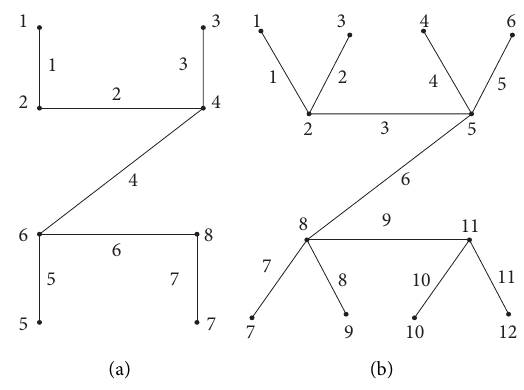
Figure 12: A classical mean labeling of SL